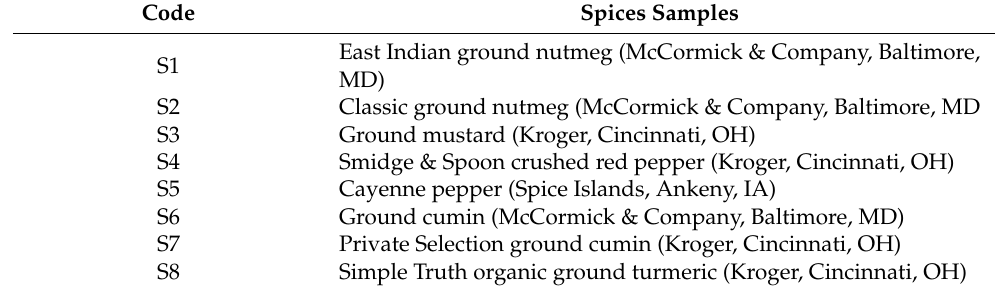
Table A5. Tested spices samples.